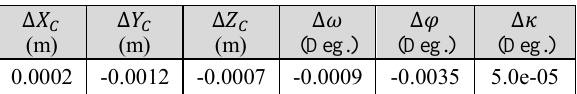
Table 5. Deviations of 6 DOF in the two aforementioned